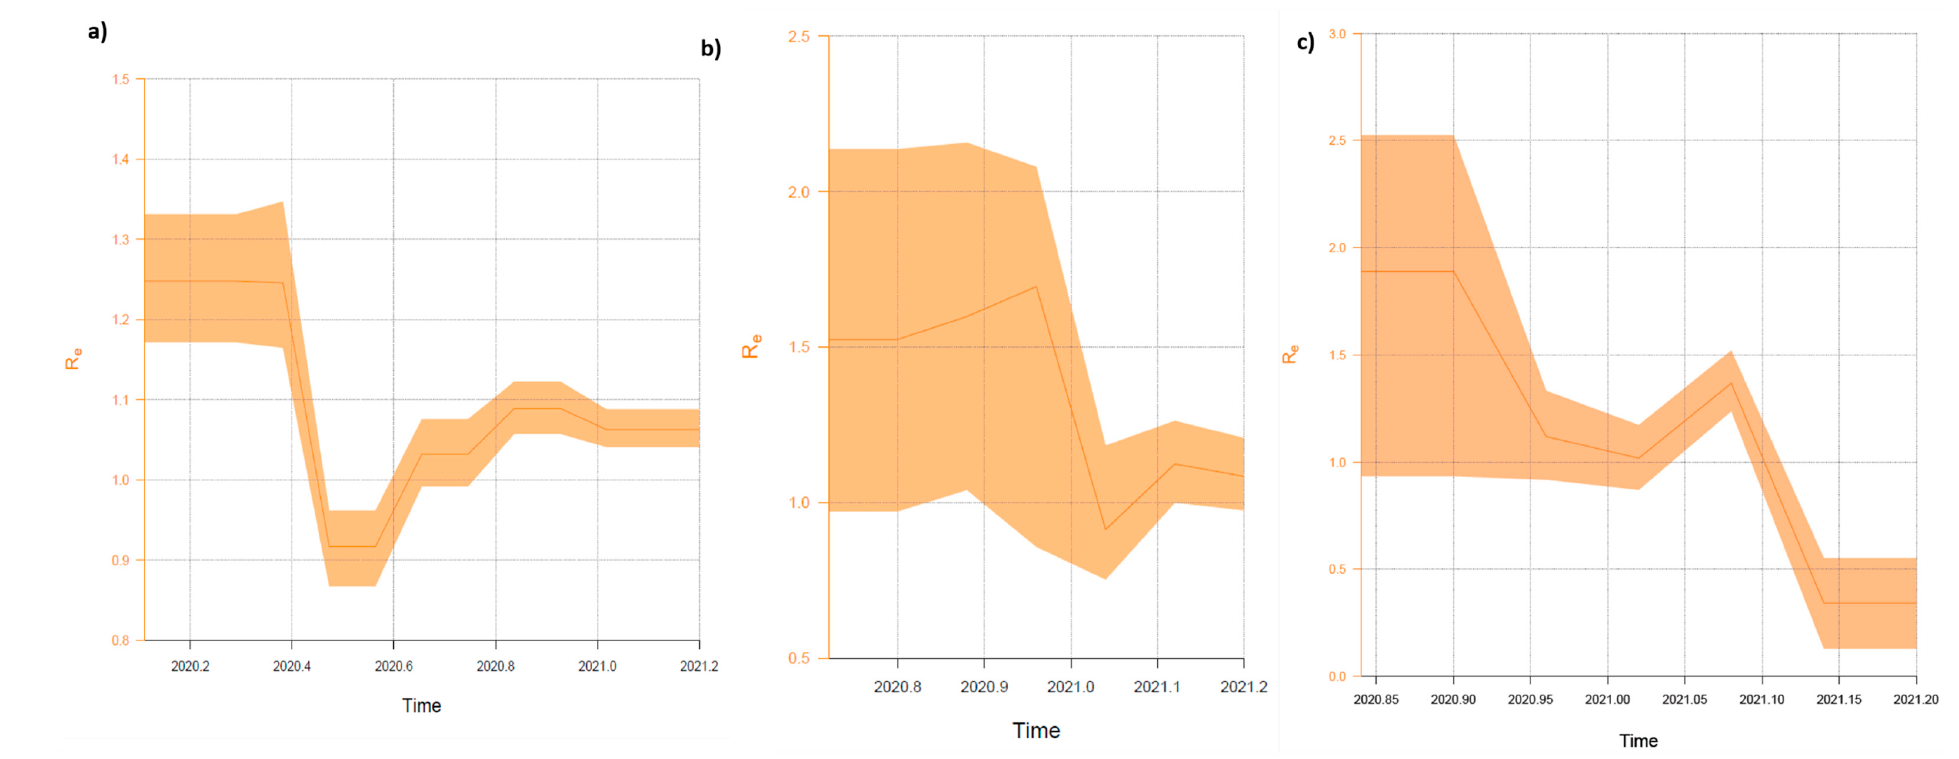
Figure 9. Birth–death skyline plot (BDSKY) of the Polish SARS-CoV-2 outbreaks. ( a ) Clade 1 (lineages: B.1.1.*—for details see Supplementary Materials); ( b ) Clade 2 (lineage: B.1.258); and ( c ) Clade 3 (lineage: B.1.221). R e estimates obtained using the BDSKY model over five equidistant intervals. The curves and the orange shaded areas show the mean R e values and the 95% confidence intervals. The Y axes indicate R values, and X axes time in years.